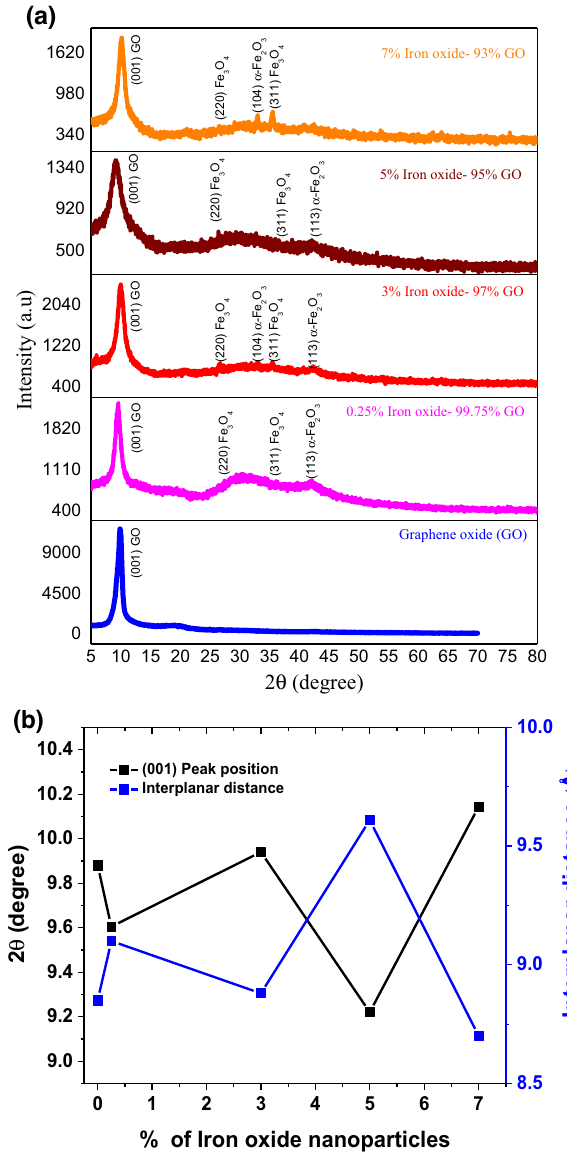
Figure 2. ( a ) XRD spectra of nanocomposite (GO/Iron-oxide) ( b ) Interplanar distance between sheets of graphene oxide in nanocomposite